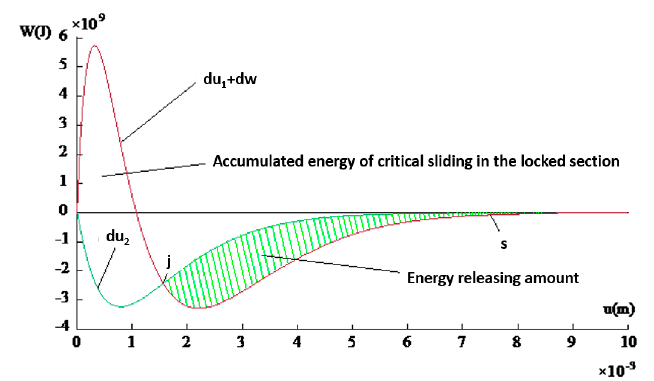
Figure 8. Energy evolution process of slope system in Washan pit.